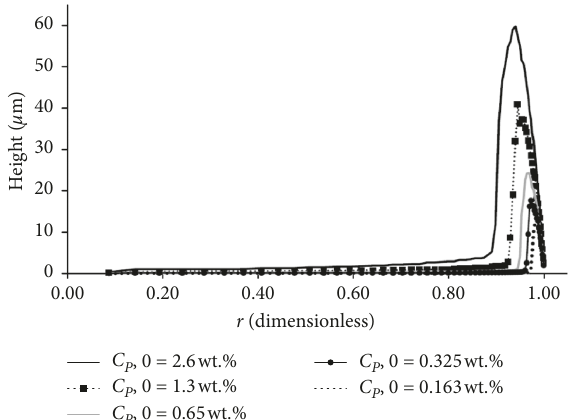
Figure 15: Effect of initial silica concentration in the sessile drop on the height and width of the ring deposit at the contact line (Pe � 138.5; Da � Da − 1 � 0; initial AR � 0.5, H �